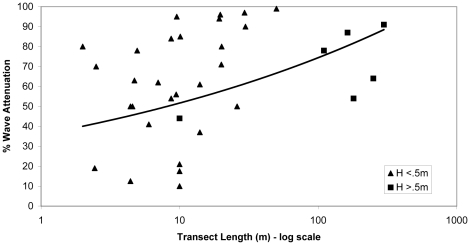
Reported wave attenuation rates through salt marsh vegetation versus marsh transect length.In most cases, the initial wave recorder was located at the marsh edge although some initial measurements were made just inside of the marsh edge. (H = wave height).